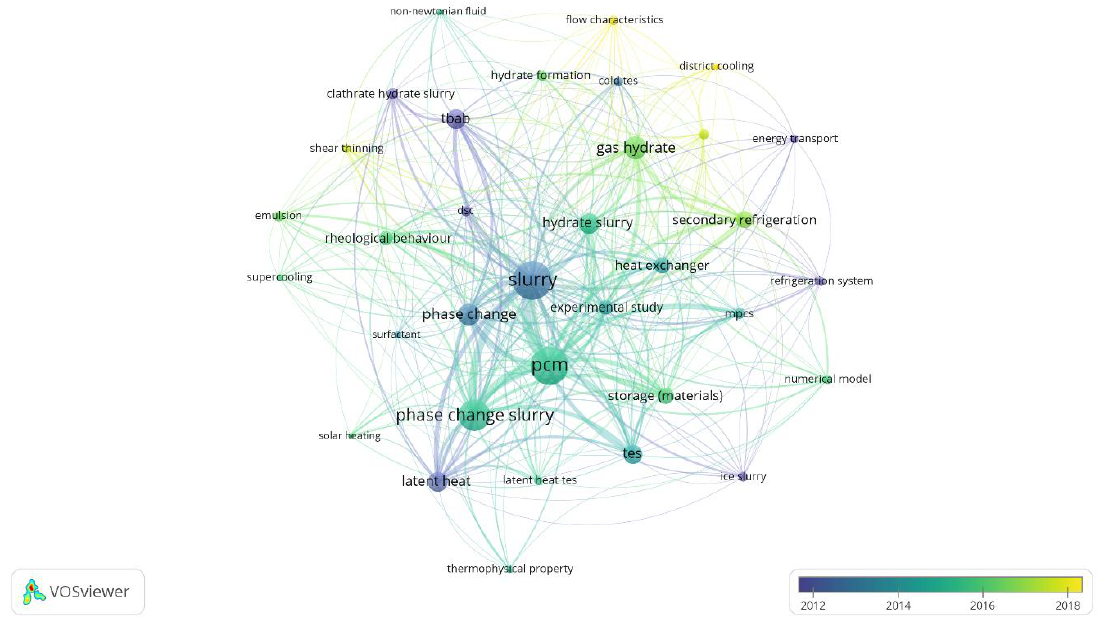
Figure 10. Overlay visualization of keywords obtained with the software VOSviewer.